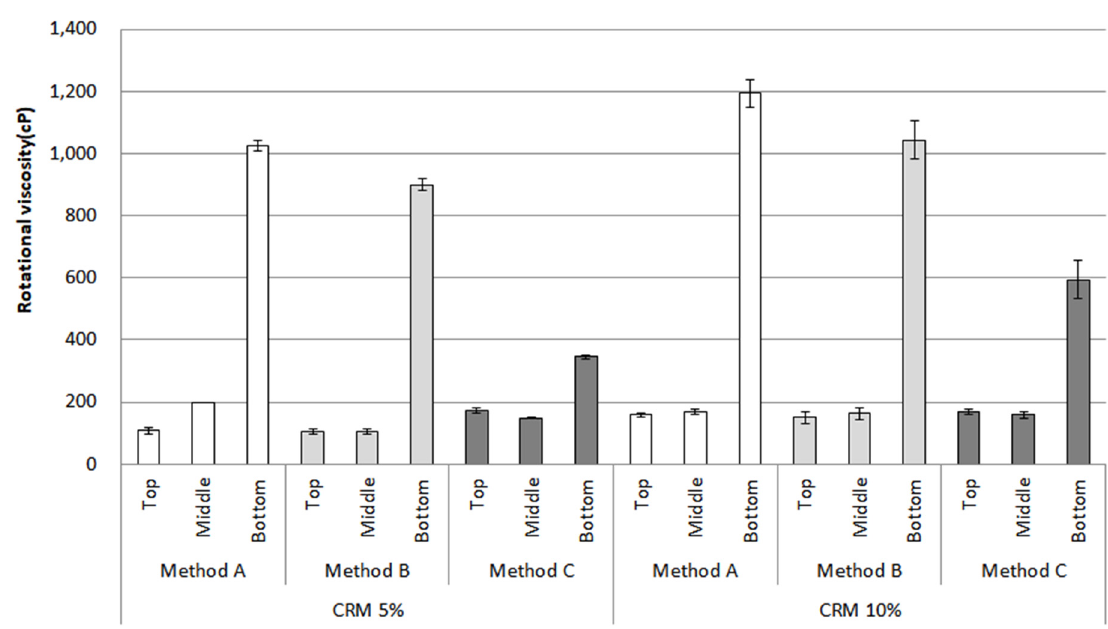
Figure 9. Rotational viscosity (180 °C) of the CRM asphalt binders in each mixing method for the top, middle, and bottom parts after conditioning.